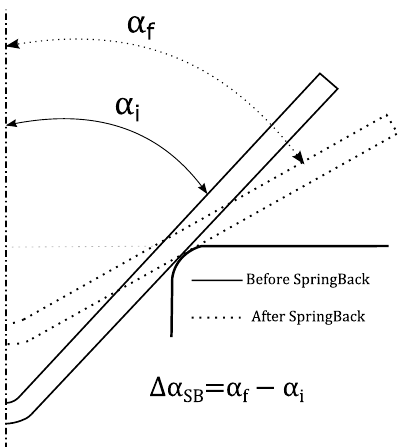
Figure 2. Definition of elastic recovery (springback) in bending process.